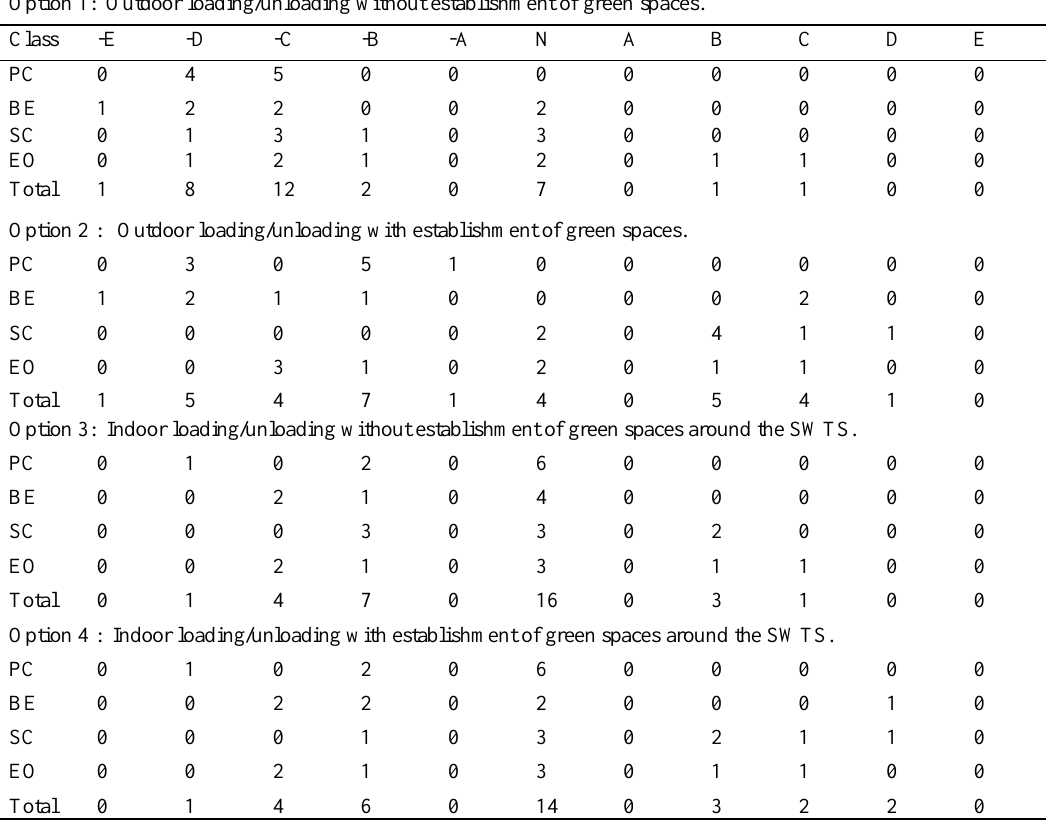
Table 5. Summary scores of RIAM analysis matrix for all potential